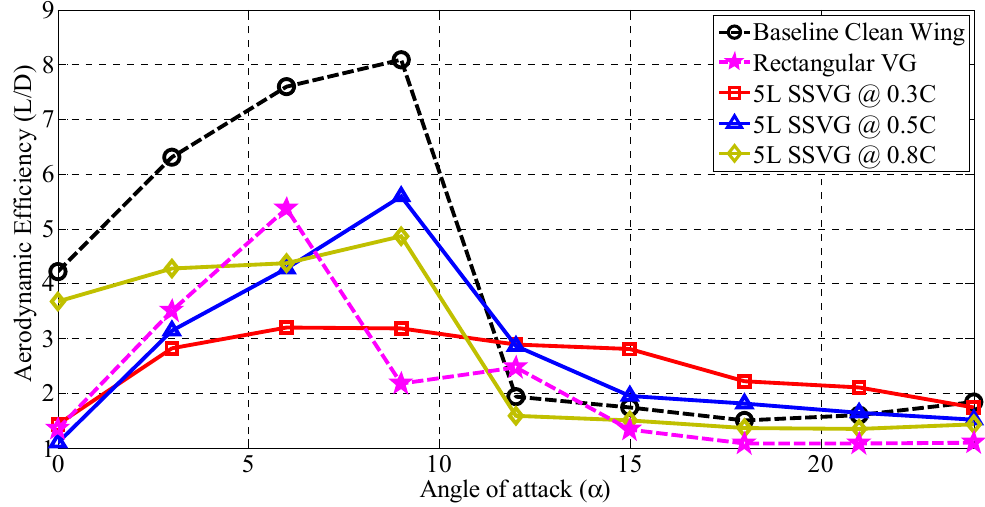
Figure 18. Aerodynamic efficiency (L/D) vs. ( α ) for baseline and modified model with large-sized (5L) SSVG.